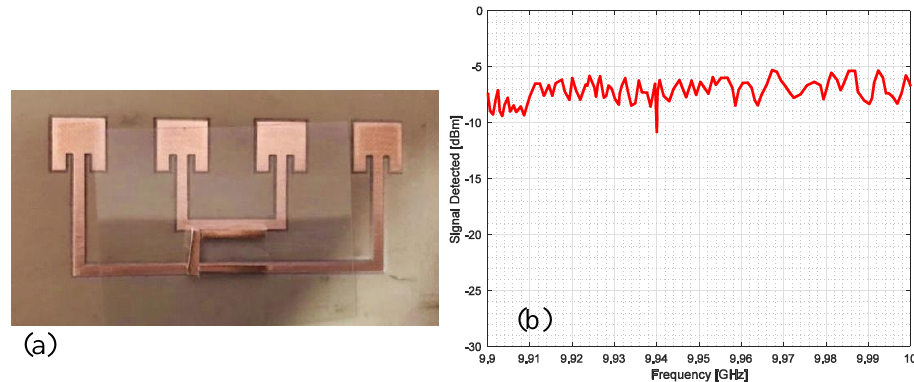
Figure 16. ( a ) Photo of a single-bit chipless Van Atta array RFID prototype fabricated on an FR4 dielectric substrate and equipped with a C resonator placed horizontally with respect to the connection microstrip. (b) Measured signal from the prototype reported in (a).